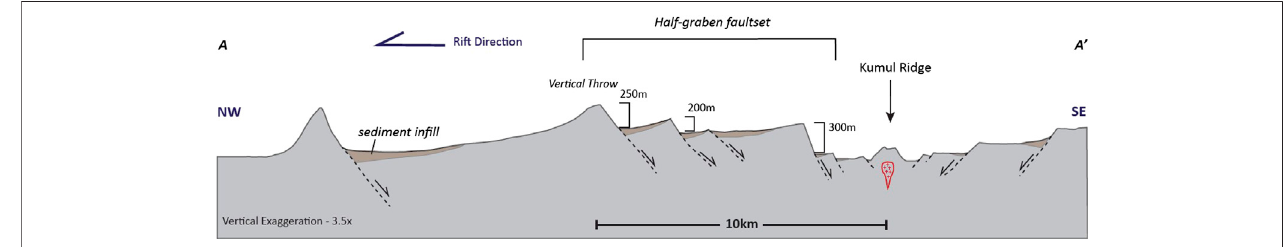
FIGURE 11 | Cross-section showing half-graben development in the northwest zone. Section line A, A 9 is shown in Figure 6 . Sediment coverage estimated from backscatter, and seismic interpretations (Martinez and Taylor, 1996; Auzende et al., 2000; Lee and Ruellan, 2006). This half-graben feature is discussed in previous